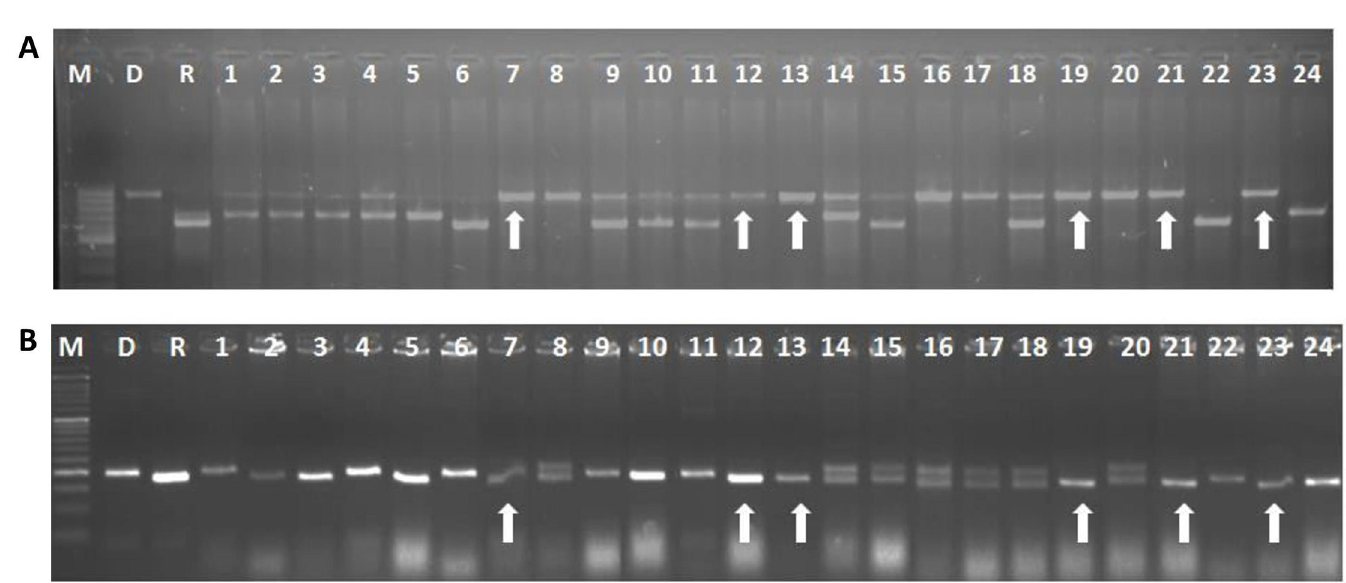
Fig 2. Screening of ICF 2 population for identification of double homozygotes for the target resistancegenes, viz., Xa21 and Xa33 . The ICF 2 plants were screened through PCR to analyze the allelic status of Xa21 (A) and Xa33 (B) using the gene-specific markers. M–Marker, R–Recurrent parent (i.e. DRR17B) and D–donor parent [i.e., ‘ ISM ’ (A) and FBR1-15EM (B)]. Arrows indicate plants which possess target genes Xa21 and Xa33 in homozygous